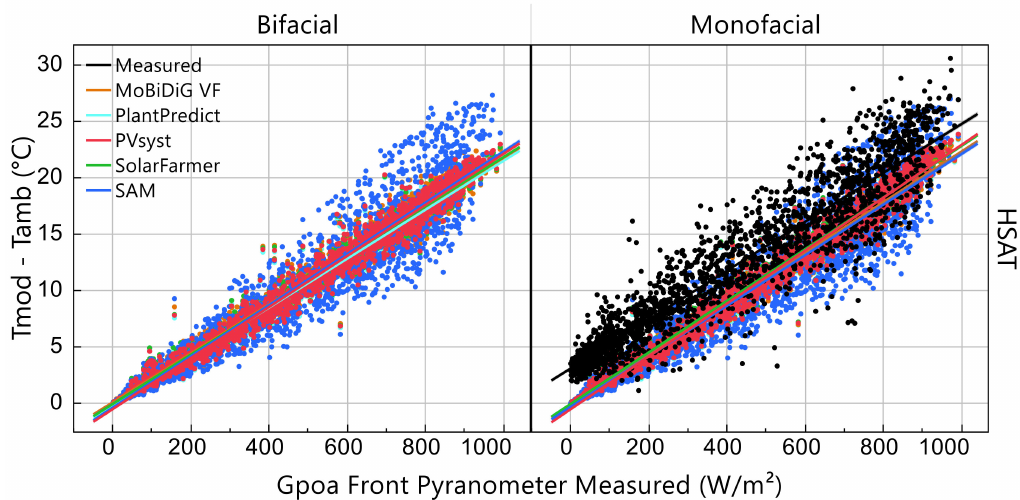
Figure 14. Temperature di ff erence of the PV module and ambient versus frontside global POA irradiance on the HSAT system. Back of module temperature measurements are shown in black and were only available for the monofacial HSAT